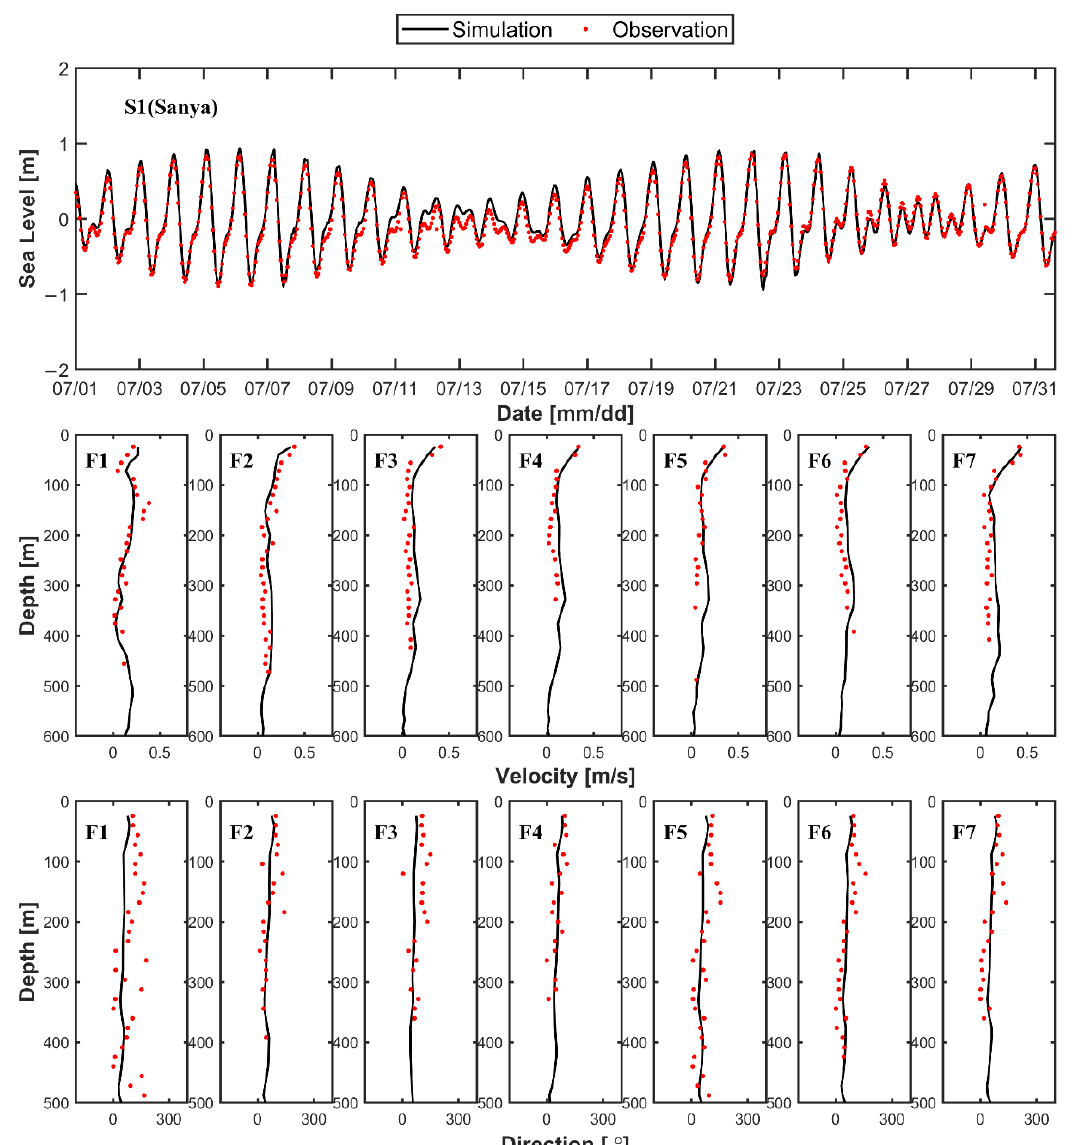
Figure 2. Model validation of sea level ( upper ), flow velocity ( middle ), and flow direction ( lower ).